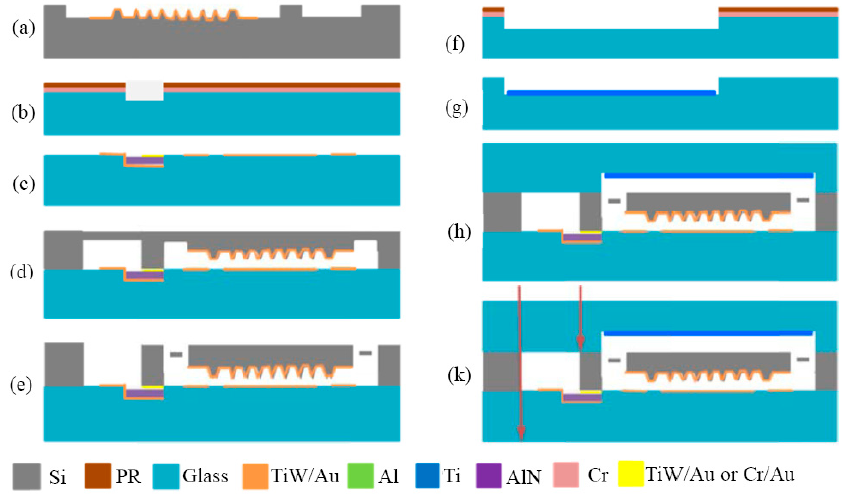
Figure 10. Major fabrication process flow for the MEMS accelerometer.